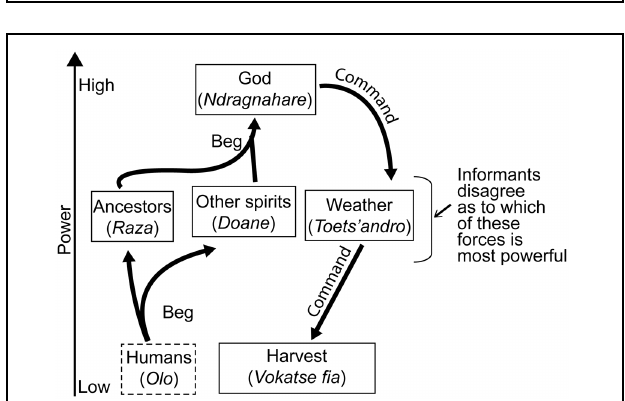
FIGURE 1 | The causal flow among God, ancestors, weather, and harvest implied by informant’s responses to pairwise questions, does X influence Y? See text for the Malagasy meaning of “influence.”